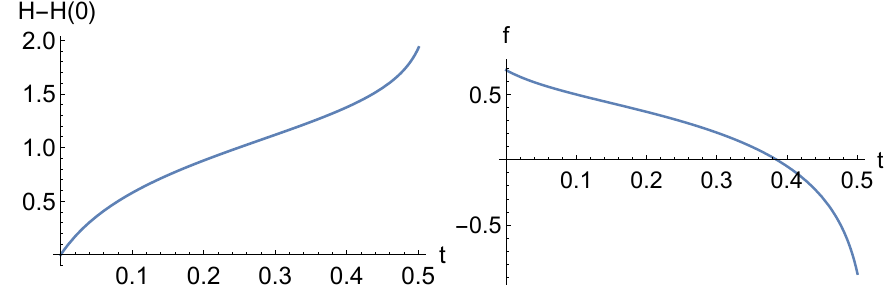
Figure 5 . H and f for the red solid curve in (cid:12)gure 3 and the red dashed curve in the left (cid:12)gure of (cid:12)gure 4 with _ f (0) = (cid:0) 3 and _ H (0) =